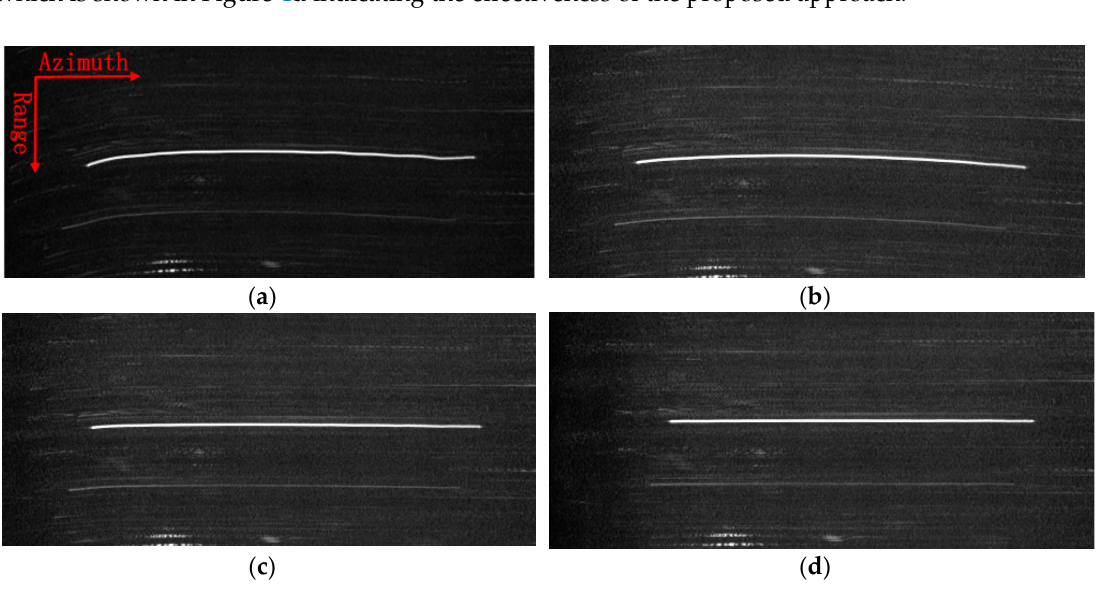
Figure 4. Target trajectory after Range Cell Migration (RCM) correction. ( a ) Without Reflectivity Displacement Method (RDM) approach; ( b ) RDM approach for stripmap mode; ( c ) RDM approach for slide spotlight mode without Weighted Total Least Square (WTLS); ( d ) RDM approach for slide spotlight mode with WTLS.